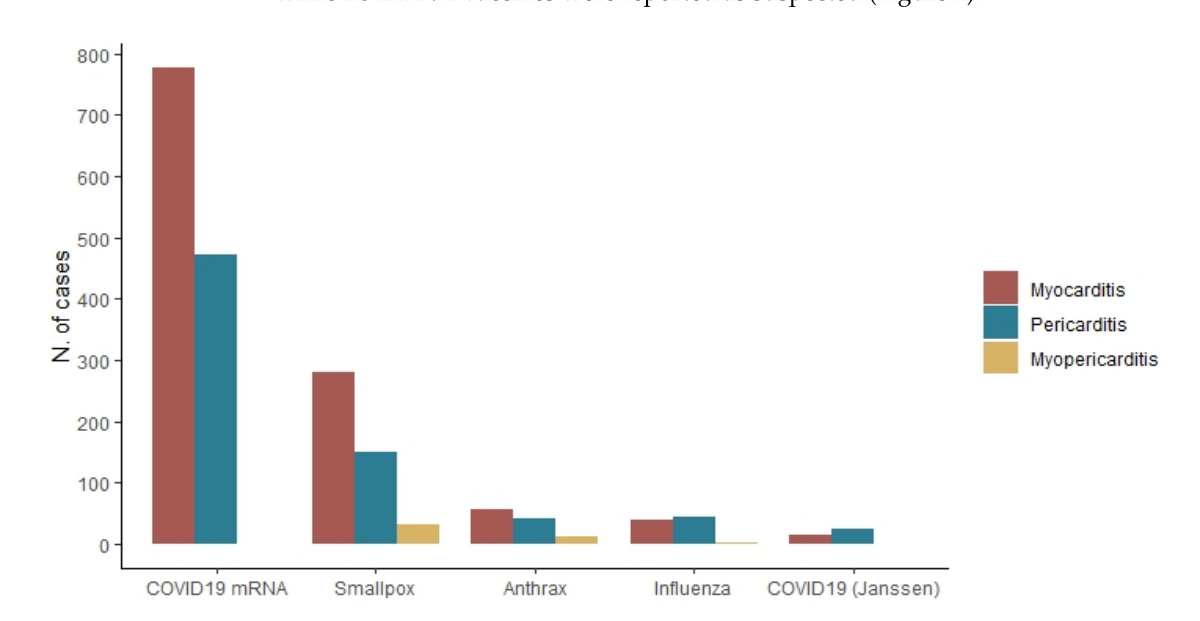
Figure 2. Distribution of myocarditis (n = 1063), pericarditis (n = 741), and myopericarditis (n = 37) by each vaccine for which study events have been reported.